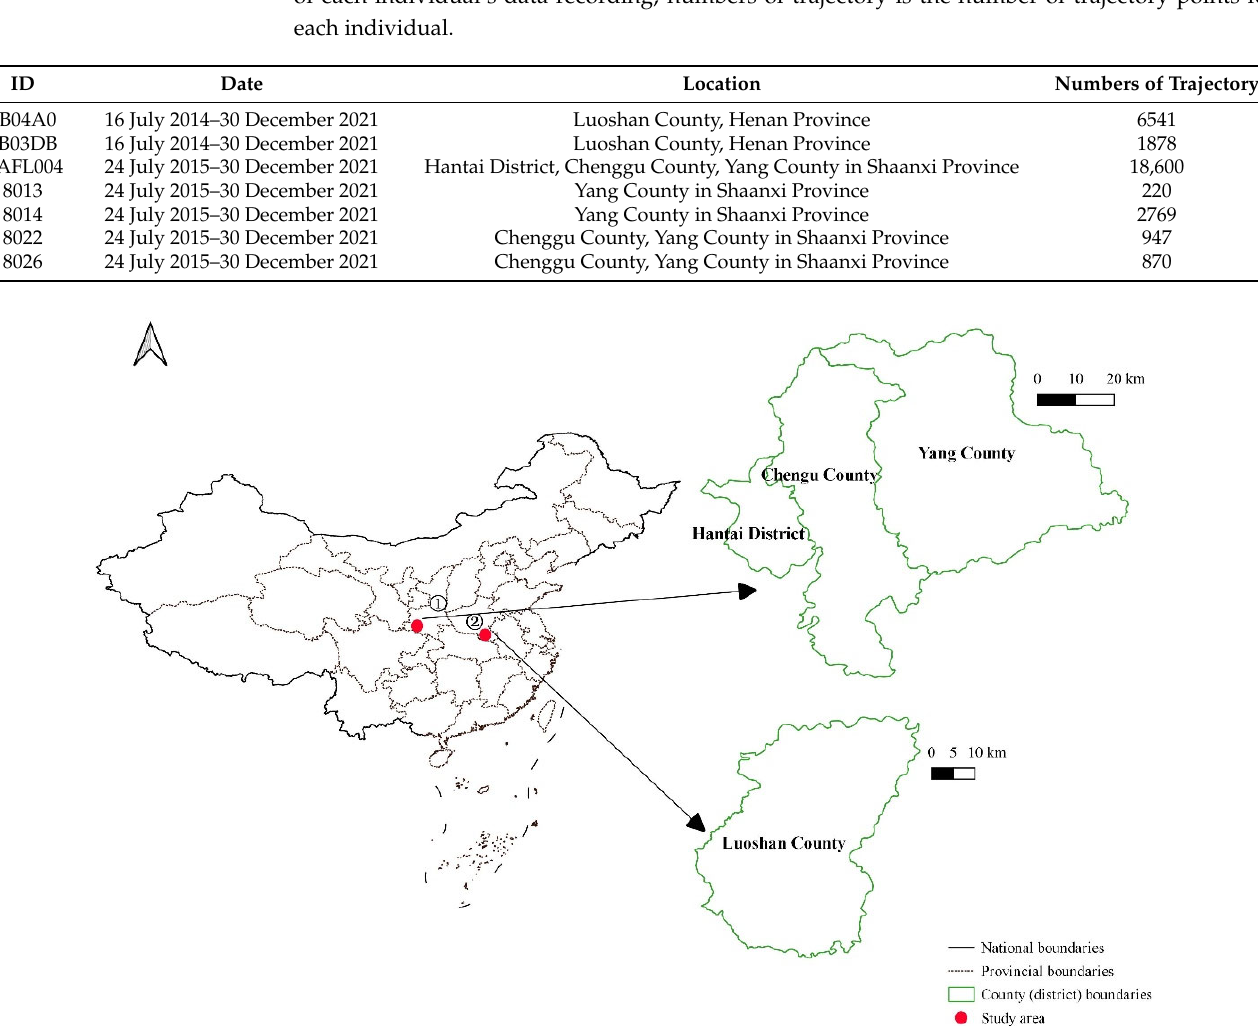
Figure 2. Location of the study area; ① in Shaanxi Province and ② in Henan Province. Multi-source environmental data were collected to study the interaction between the Crested Ibis and its environment and to analyze its biological patterns and behavior (Table 2). They were DEM (digital elevation model) data, NDVI (normalized difference vegetation index) vegetation-index data, OSM (open-street map) road data, river-distribution vector data, and GlobeLand30 land-cover data (Table 2). The data set of DEM in Geospatial Data Cloud was ASTER GDEM 30M and the location was Luoshan County, Xinyang City, Henan Province. The data set of NDVI in Geospatial Data Cloud was MOD13Q1